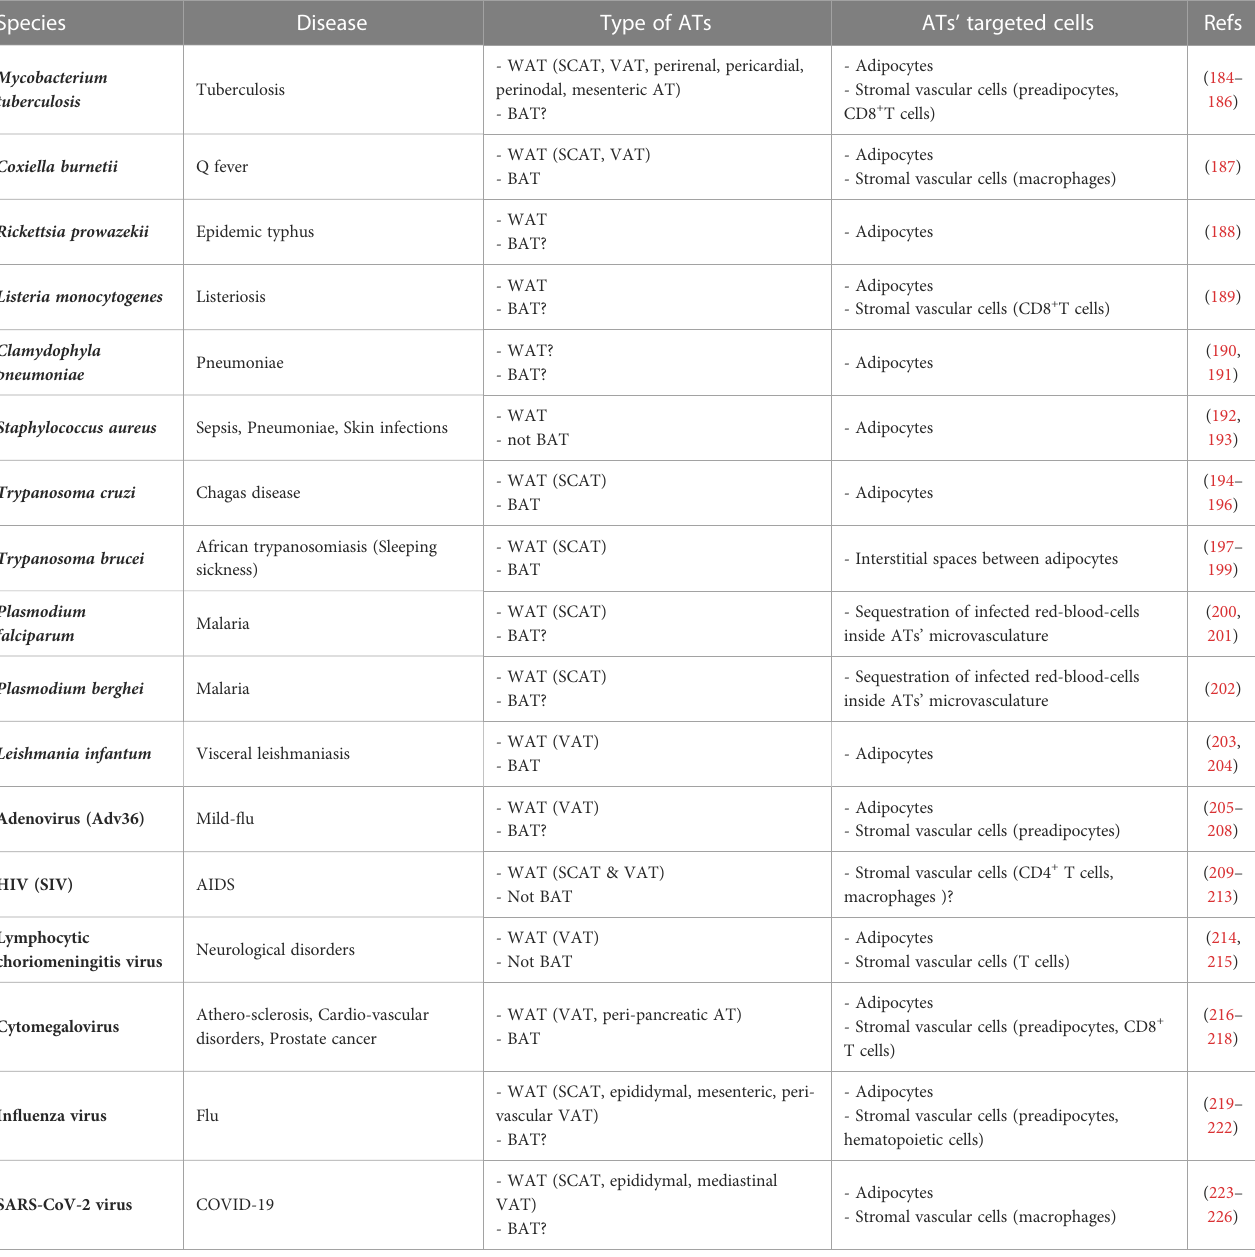
TABLE 2 Pathogens found in adipose